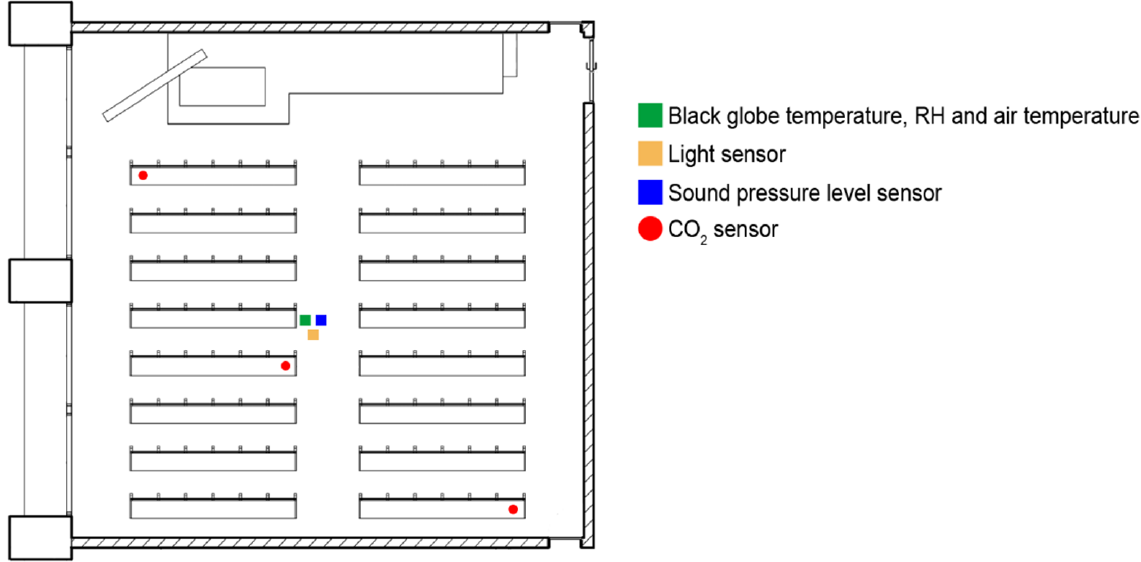
Figure A1. Layout of the sensor location in classroom.